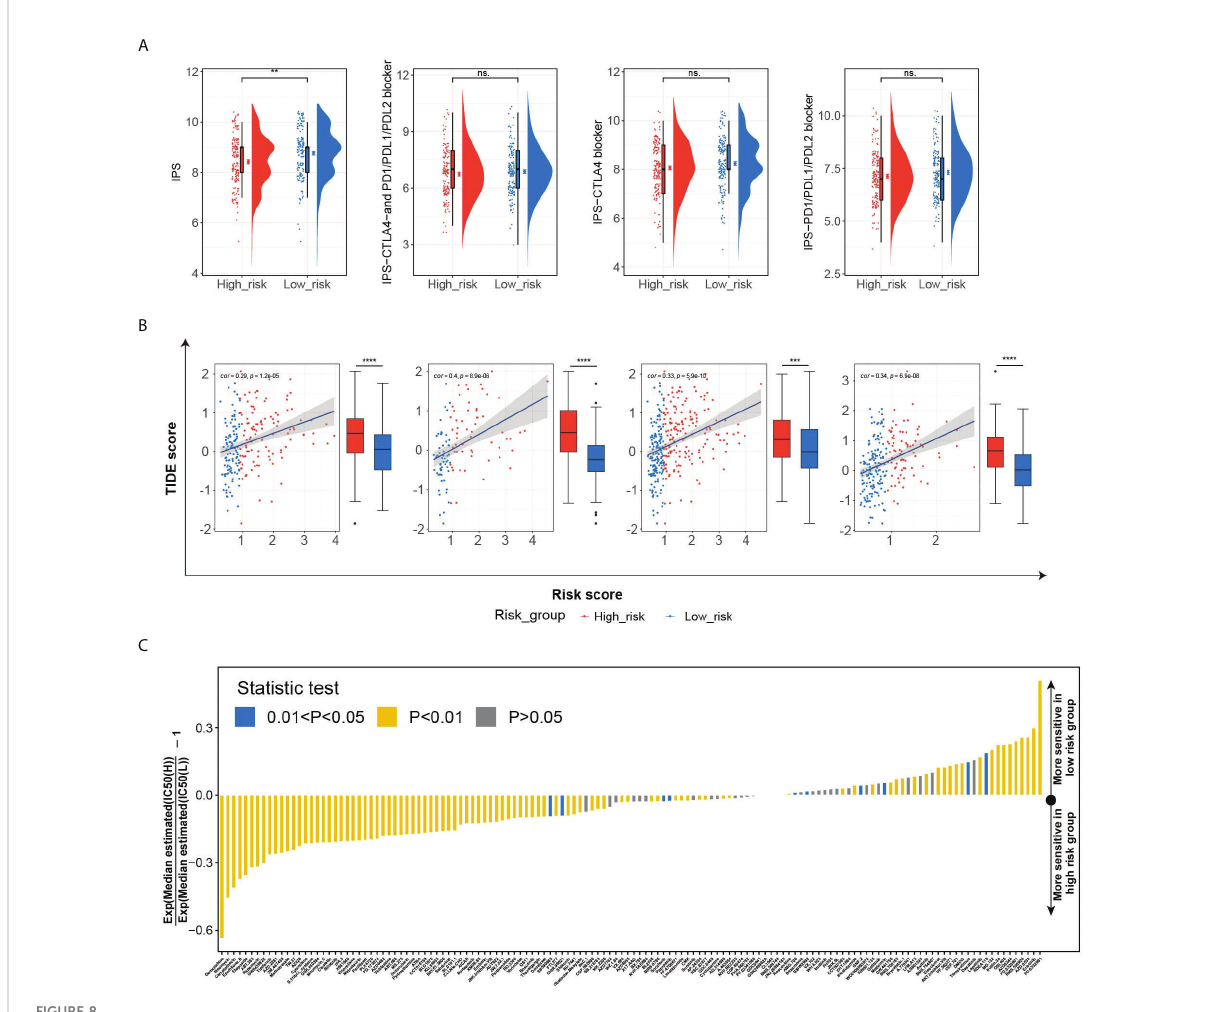
FIGURE 8 The potential role of HGSIS in predicting therapeutic sensitivity. (A) The correlation between HGSIS and IPS based on the whole TCGA cohort. (B) Distribution of TIDE scores in the TCGA training set, TCGA validation set, whole TCGA cohort, and ICGC-LIRI-JP dataset. (C) Estimation of 138 drugs ’ normalized IC 50 values. ** p < 0.01, *** p < 0.001, **** p < 0.0001, ns, not signi fi